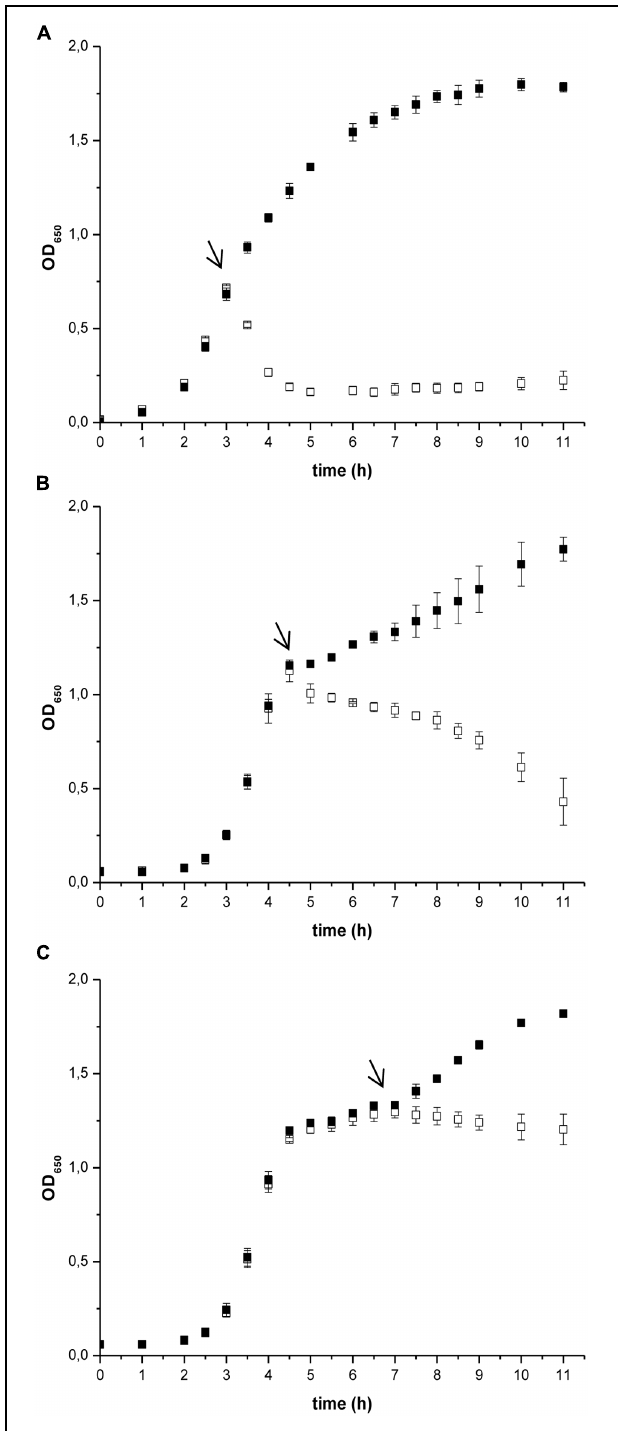
FIGURE 1 | The effect of prodigiosin addition on Bacillus subtilis PS-216 wt growth in LB medium at 37 ◦ C and 200 rpm at different growth phases. The arrows represent the time of addition of 5.9 mg L − 1 prodigiosin (opened squares) or 0.19% (V/V) ethanol in the control samples (filled squares). (A) cells treated in the middle of the exponential phase; (B) cells treated in the late exponential phase; (C) cells treated in the stationary phase. Data are presented as averages and standard deviations ( n =